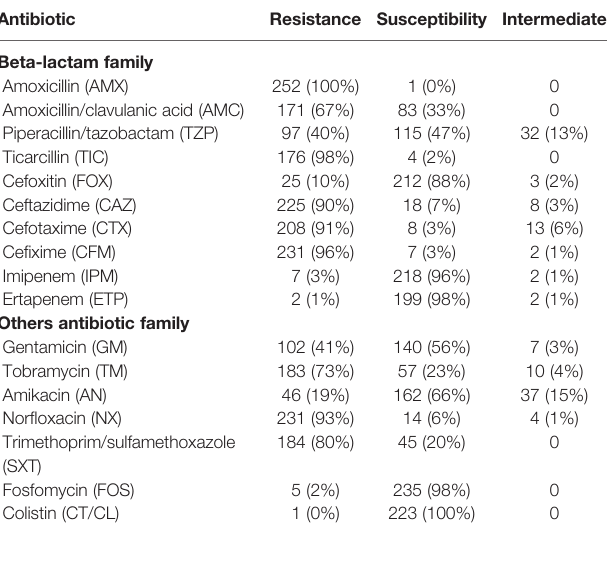
TABLE 2 | Resistances among ESBL-producing E. coli